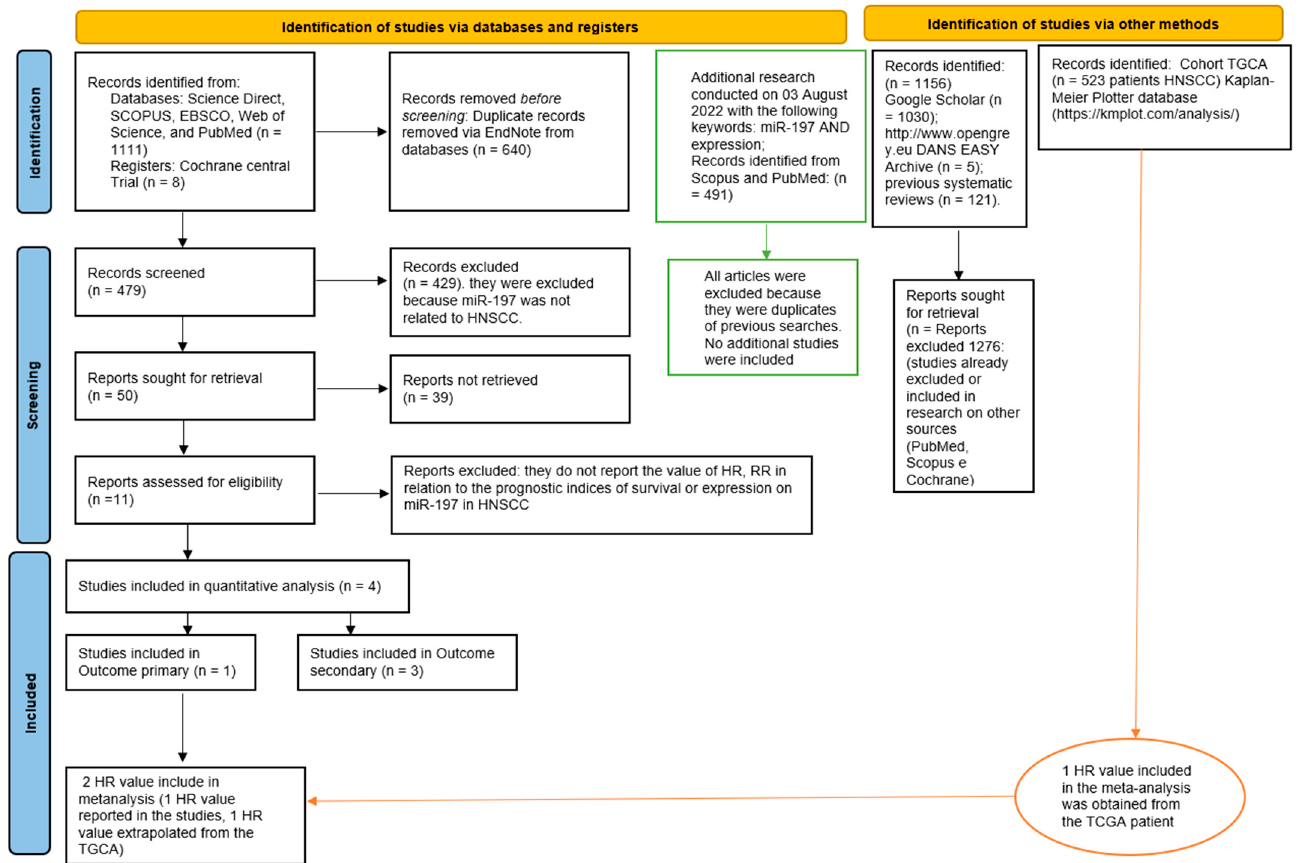
Figure 1. Entire selection and screening procedures are described in the PRISMA flowchart. In total, 2 HR (Hazard Ratio) values were included in the meta-analysis; the first value was taken from the study included in the primary outcome, and the second HR value was obtained from the bioinformatics analysis of the TGCA cohort. After the removal of duplicates, 429 studies were excluded since miR-197 was only mentioned in the text or not related to HNSCC. Subsequently, 39 more studies were excluded because they did not report any miR-197 expression values or prognostic indices of survival. In the green boxes, a further search of articles is shown, which was conducted on August 3, 2022, and did not lead to the inclusion of any additional studies.